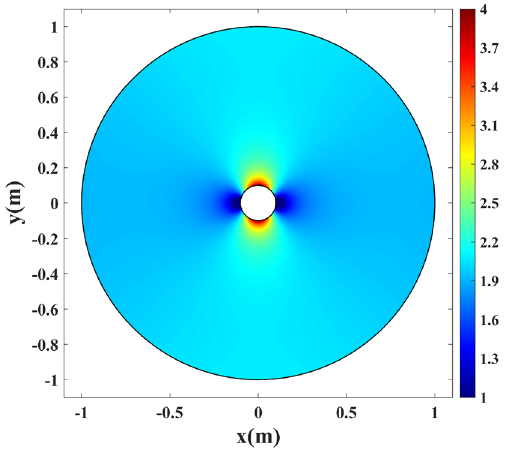
Figure 9. The modified refractive index profile in Fig. 5. The background refractive index is changed to 2 and the superluminal index values are replaced with a unity refractive index.